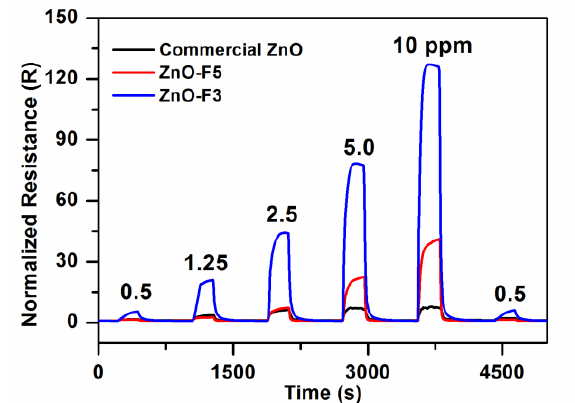
Figure 9. Dynamic response curve of the sensor prepared from F3, F5 and commercial ZnO samples to NO with concentrations ranging from 0.5 ppm to 10 2